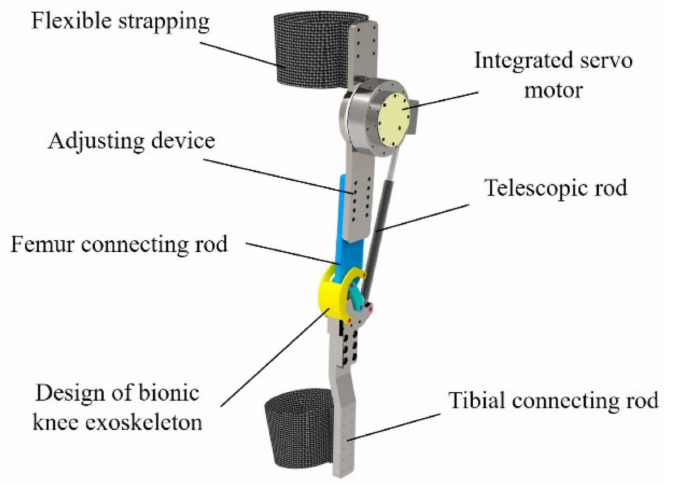
Figure 11. Knee locking mechanism.